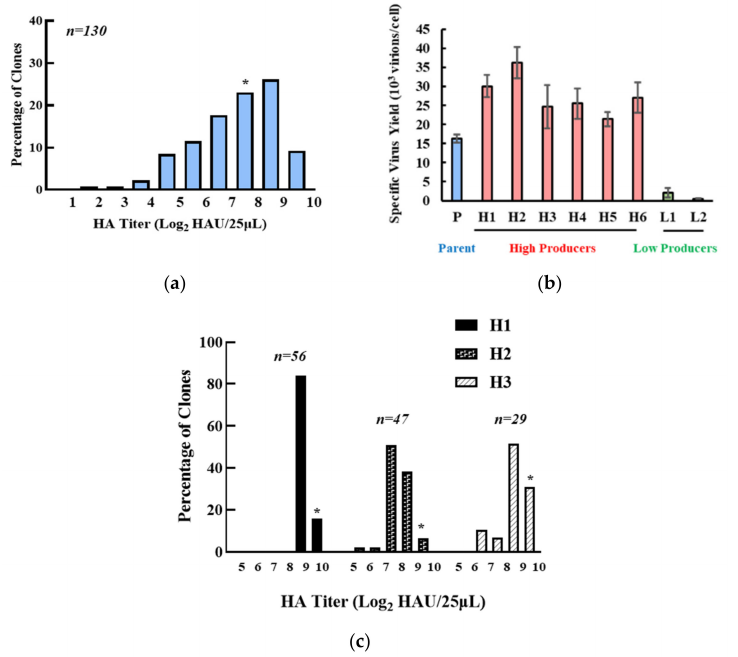
Figure 1. Clonal variation of parental MDCK cells. ( a ) clonal HA titer distribution of parental MDCK cells. ( b ) specific virus yield of selected high- or low-producing clones. Red: High-producing clones, blue: Parent cells, green: Low-producing cells. Experiments were done in triplicated infections. ( c ) HA titer distribution of H1, H2, and H3 subclones after an 80-day passage. * indicates HA titer of the pool.